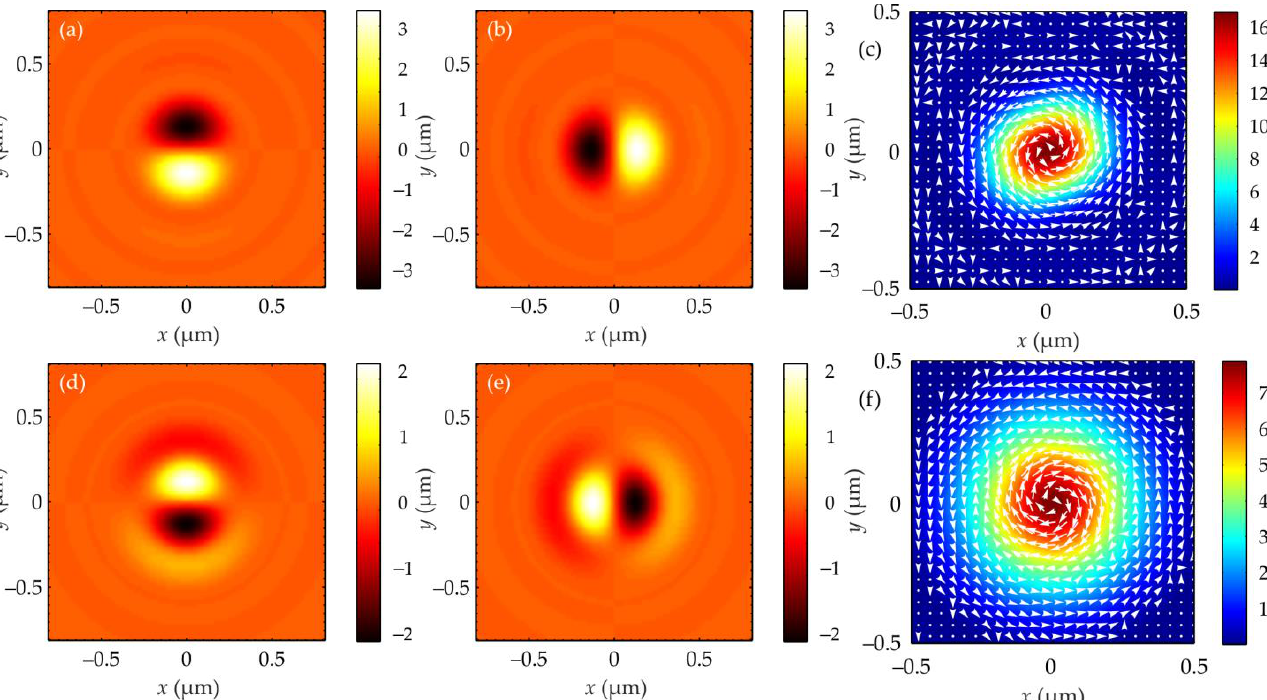
Figure 2. Patterns of the transverse energy flow (Poynting vector projections) at the tight focus: P x ( a , d ), P y ( b , e ) and the direction (arrows) of rotation of the transverse energy flow against the intensity background ( c , f ) for two different Poincar é beams: θ = π /4, ψ = π /4, n = 0 ( a , b , c ); θ = π /4, ψ = π /4, n = 1 ( d , e , f